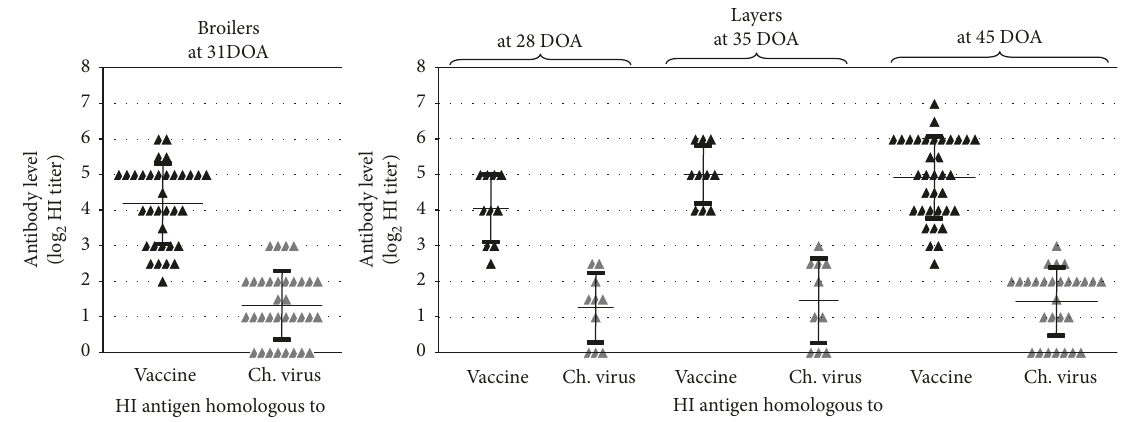
Figure 2: Humoral immune response to vaccination in commercial broilers and commercial layers without MDA to AIV H5N1. Hemagglutination inhibition test was performed parallel with the antigen homologous to the vaccine and with the antigen prepared from the challenge virus. Age of birds at sampling is shown above the graph (DOA=days of age). Mean titer and standard deviation is shown as a horizontal bar with whiskers. Positivity limit is at least 3 log HI titer. 2